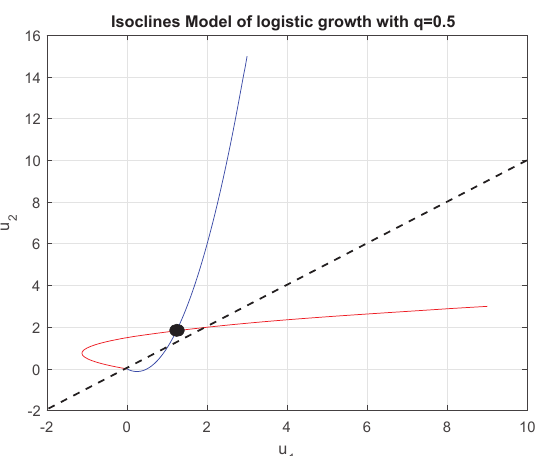
Figure 1. The phase plane of system (1) in case the growth rate is logistic, parameterized here as u i / k i ) , i = 1,2. Red and blue curves show the isoclines (3) a square polynomial f i ( u i ) = r i u i ( 1 − obtained for hypothetical parameter values r 1 = r 2 = 1, k 1 = 0.5, k 2 = 2 and q = 0.5. The black dot shows the positive steady state, the black line is the bisector